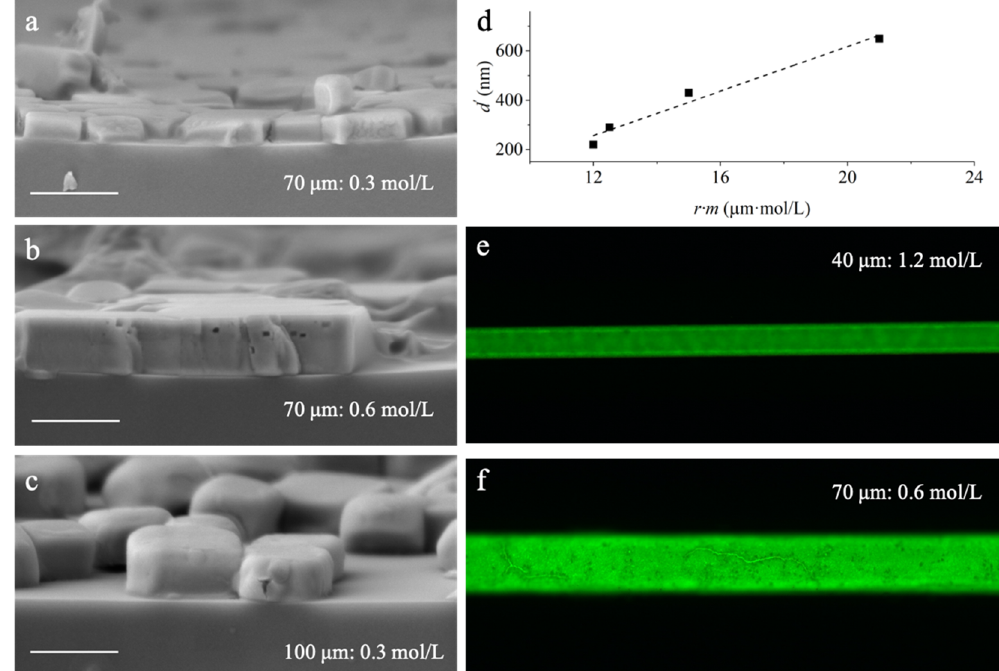
Figure 5. Flow velocity controlled uniform solvente. ( a – c ) Cross-section SEM images of inner-surfaces of perovskite-coated capillaries with varied capillary diameters and concentrations of precursor solutions. Scale bar: 1 μm. ( d ) Linear thickness dependence described by Equation (2). ( e , f ) The film assembly results applying diameter-optimized precursor concentra- tions.